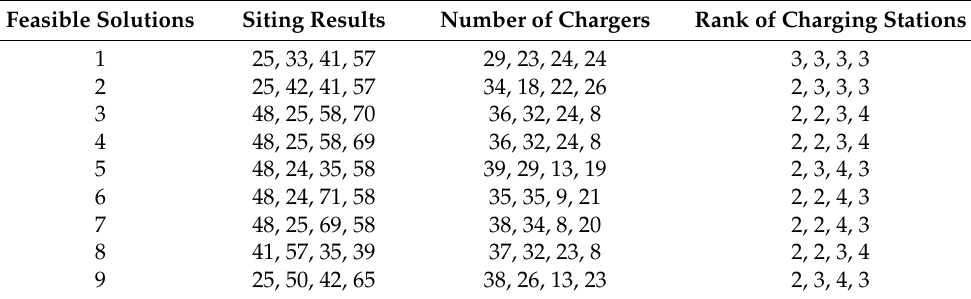
Table 5. The siting results of the lower